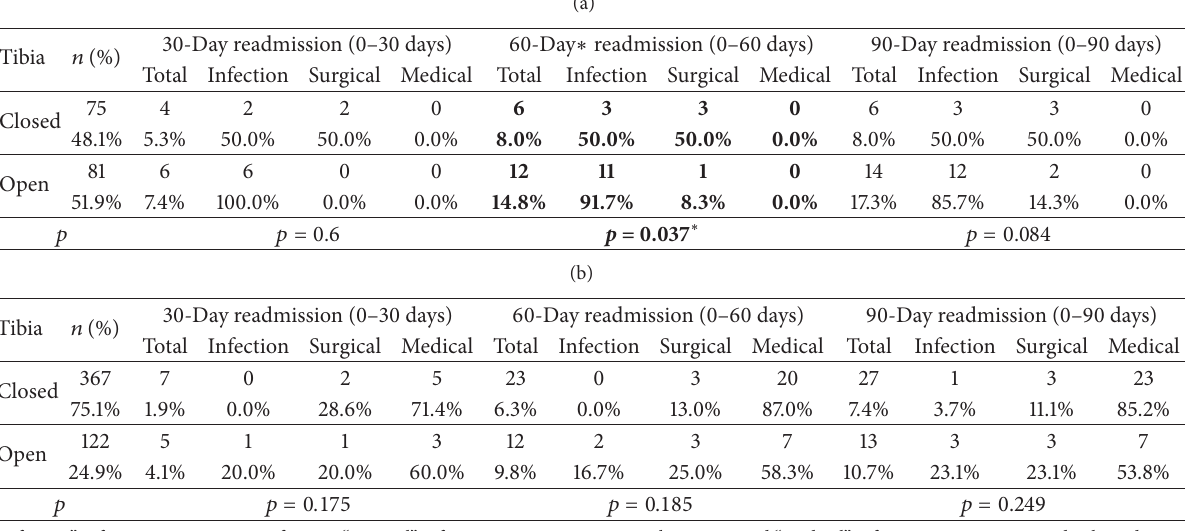
“Infection” refers to postoperative infection, “surgical” refers to postoperative surgical revision, and “medical” refers to nonoperative medical conditions such as UTIs, PNAs, hypotension, and anemia. ∗ There is a significant difference between the 60-day readmission rate for patients with closed tibia fractures and patients with open tibia